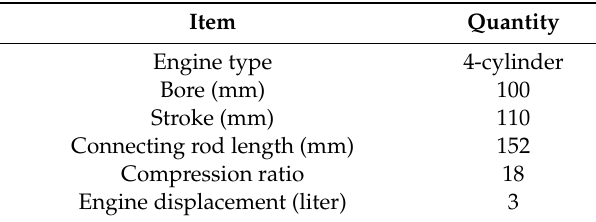
Figure 3. Schematic diagram of SCR after-treatment system for simulation. Table 1. The detail parameters of the